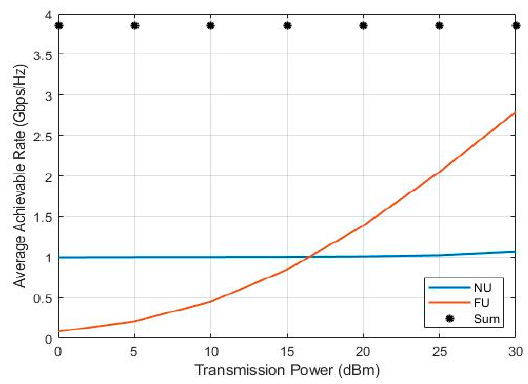
Figure 7. Achievable rate vs. transmit power .